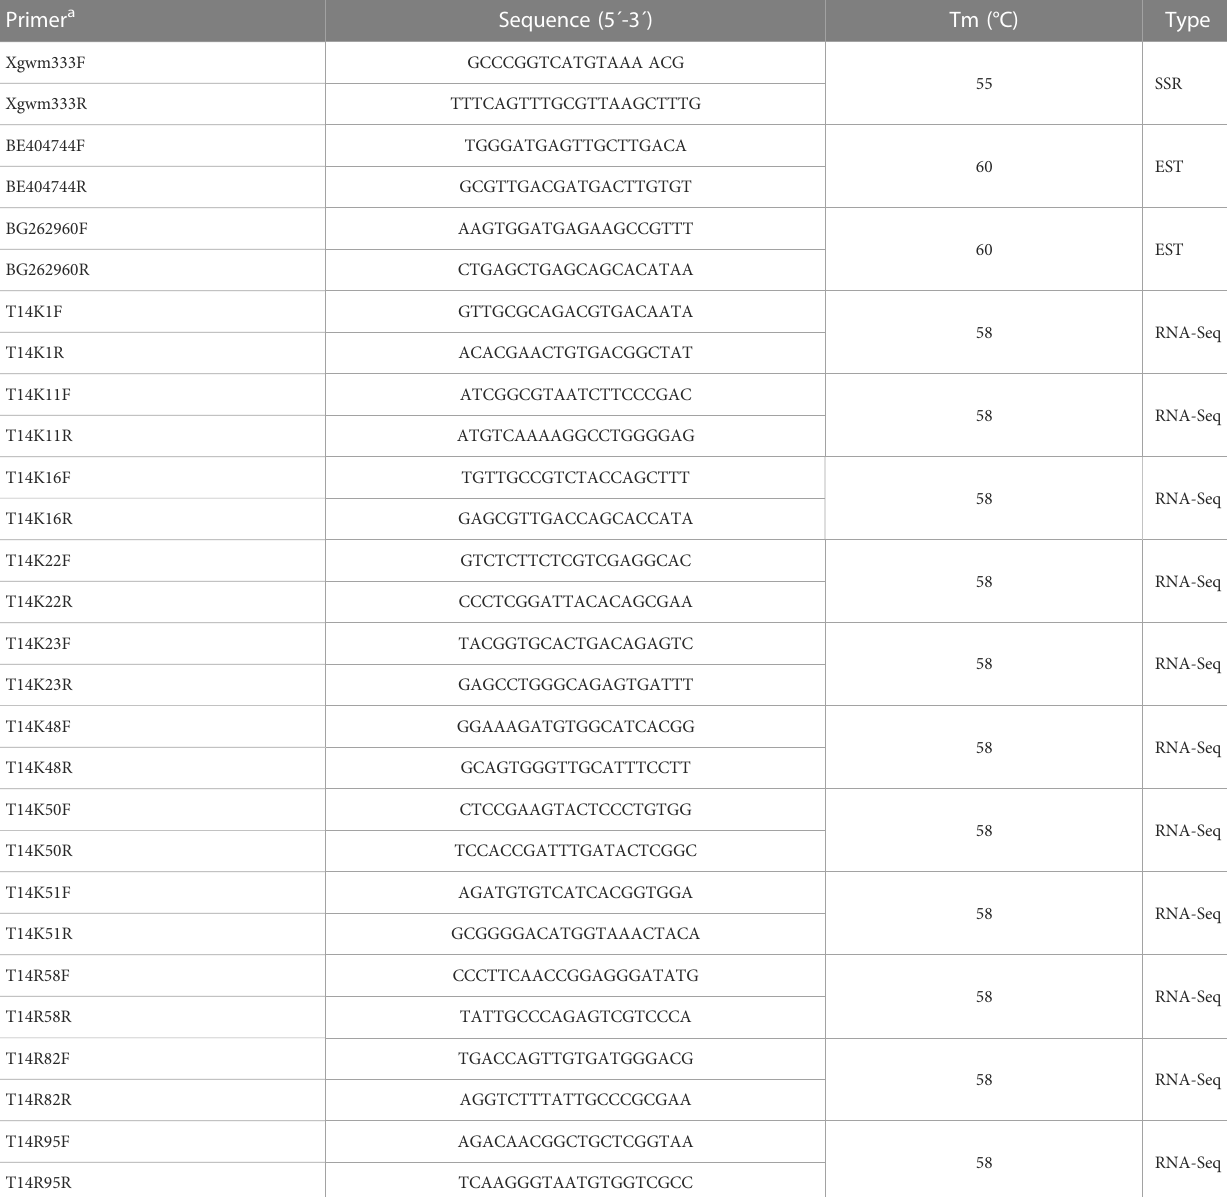
TABLE 4 Speci fi c markers and primer sequences for the alien telocentric chromosome. Primer a Sequence